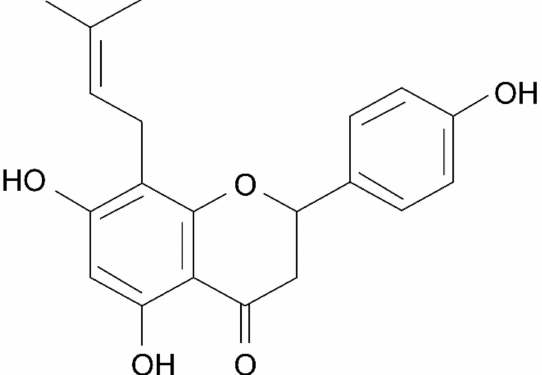
Figure 14. The chemical structure of 8–prenylnaringenin. Reprinted from Jelle, D.K.; Geert, O.; Arne, H., et al. Formation and Accumulation of α -Acids, β -Acids, Desmethylxanthohumol, and Xanthohumol during Flowering of Hops (Humulus lupulus L.), with permission. Copyright © 2003, American Chemical Society